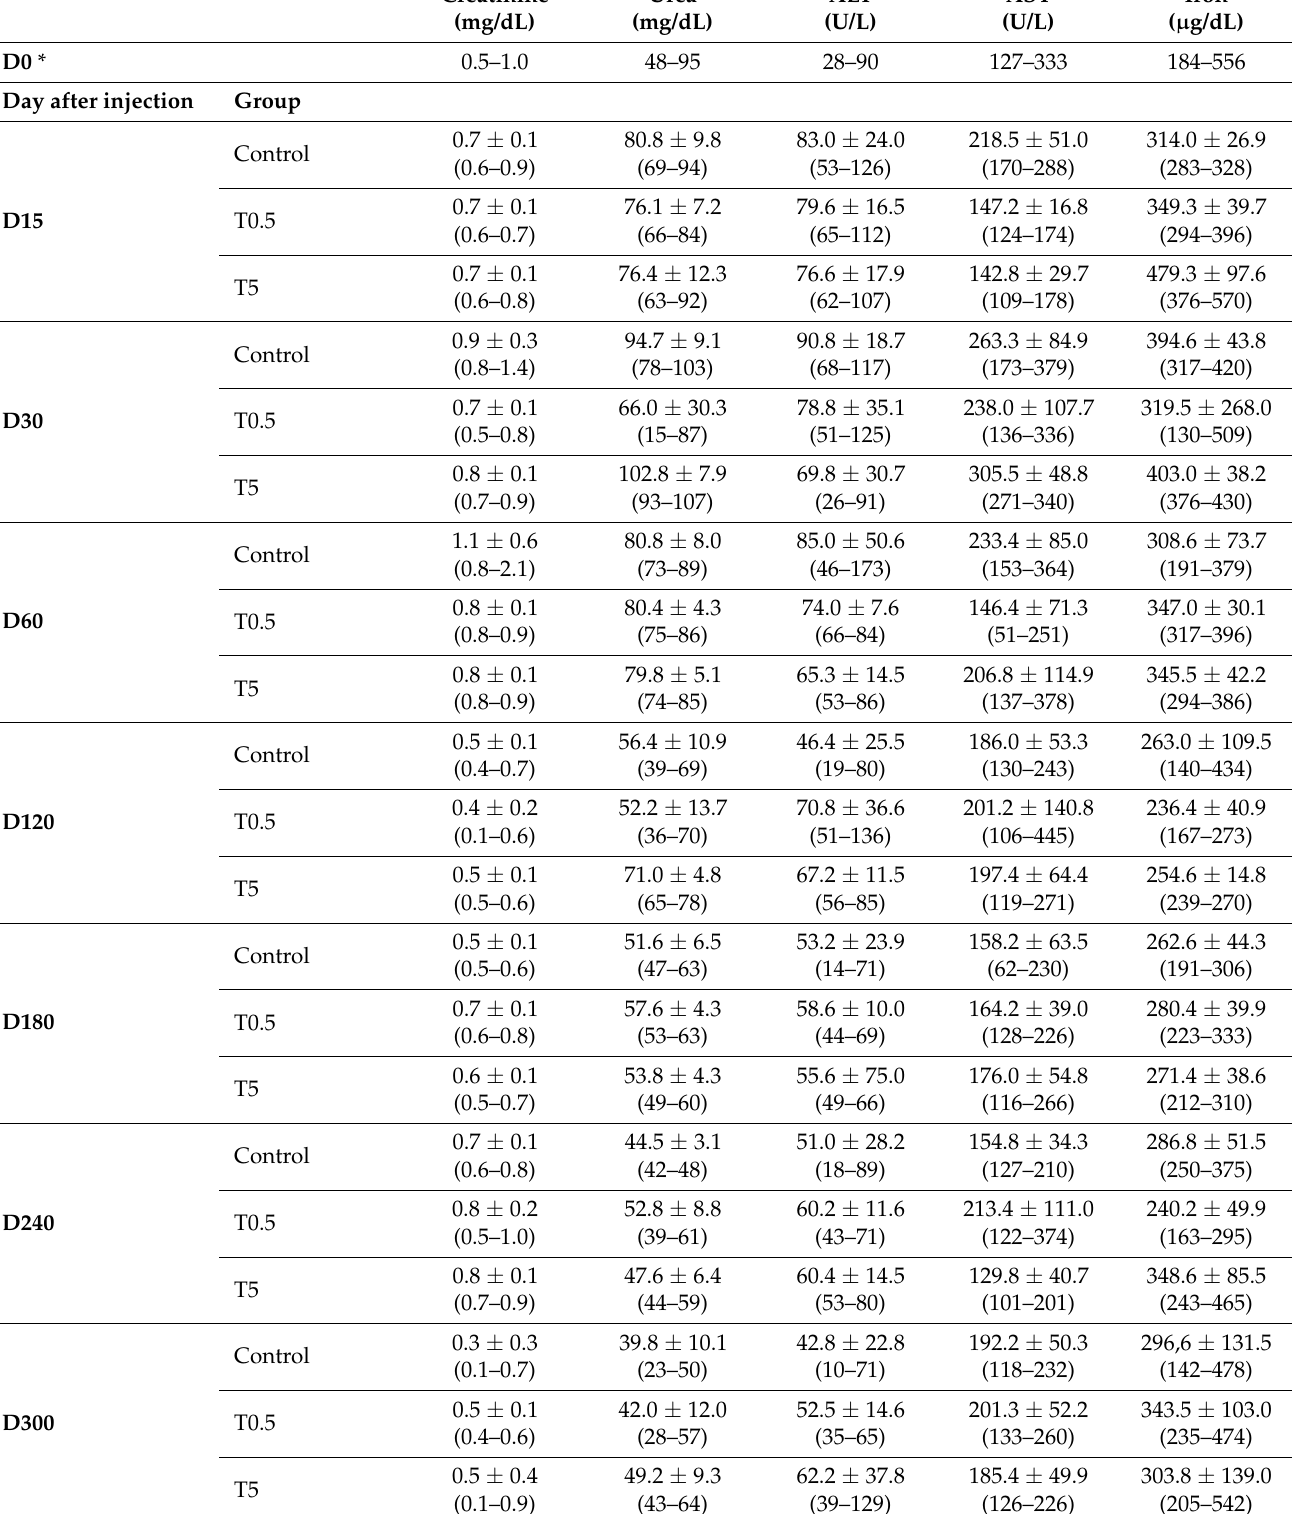
Table 2. Results of serum biochemical analyses from control and treated animals. Complete data are shown in Supplementary Tables